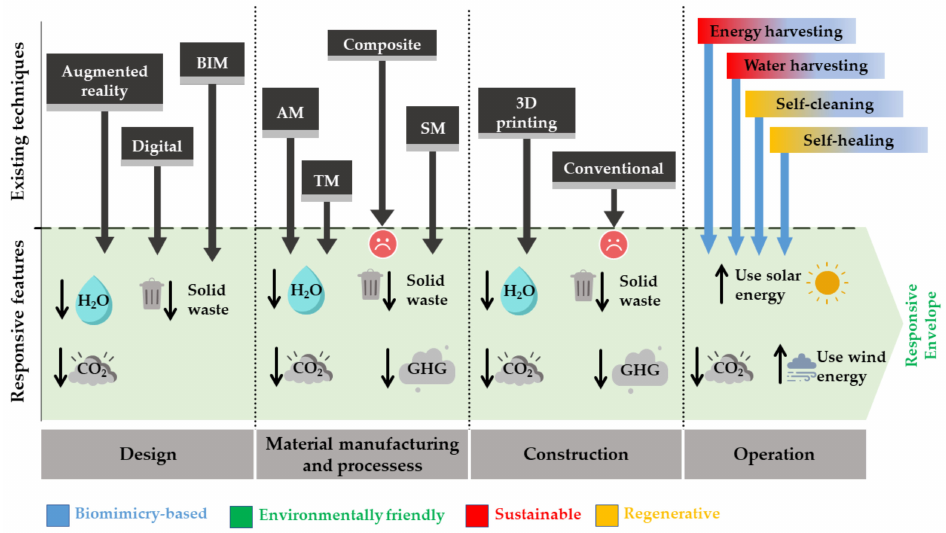
Figure 2. A framework to present current research regarding techniques, materials, and manufactur- ing techniques towards achieving responsive envelopes, highlighting the bridge (dashed horizontal line) and research gaps (sad face). Arrow directions refer to: down (decrease) and up